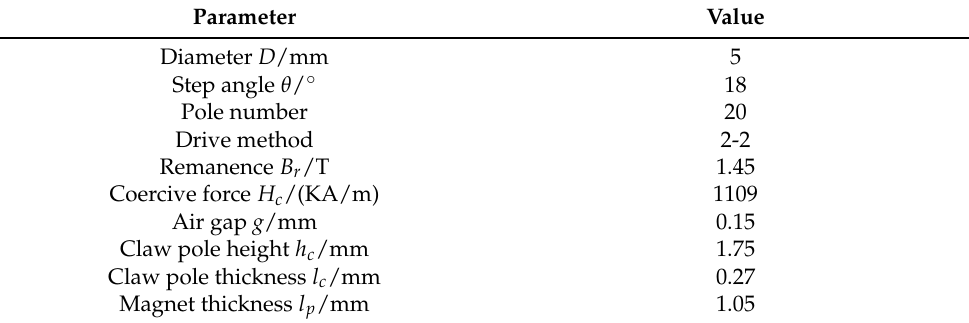
Table 1. Basic parameters of micro-claw